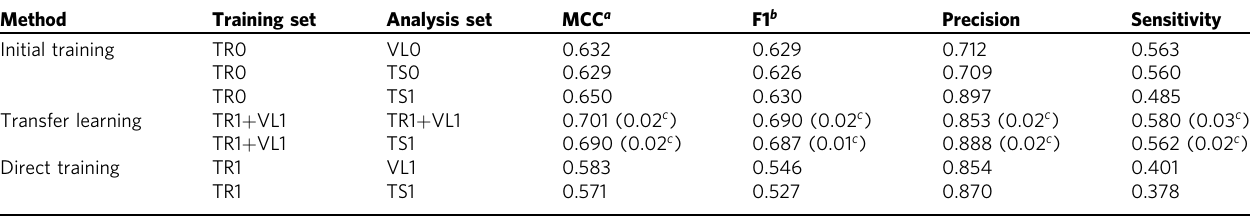
Table 1 Performance of SPOT-RNA on validation and test set after initial training, transfer learning, and direct training. Method